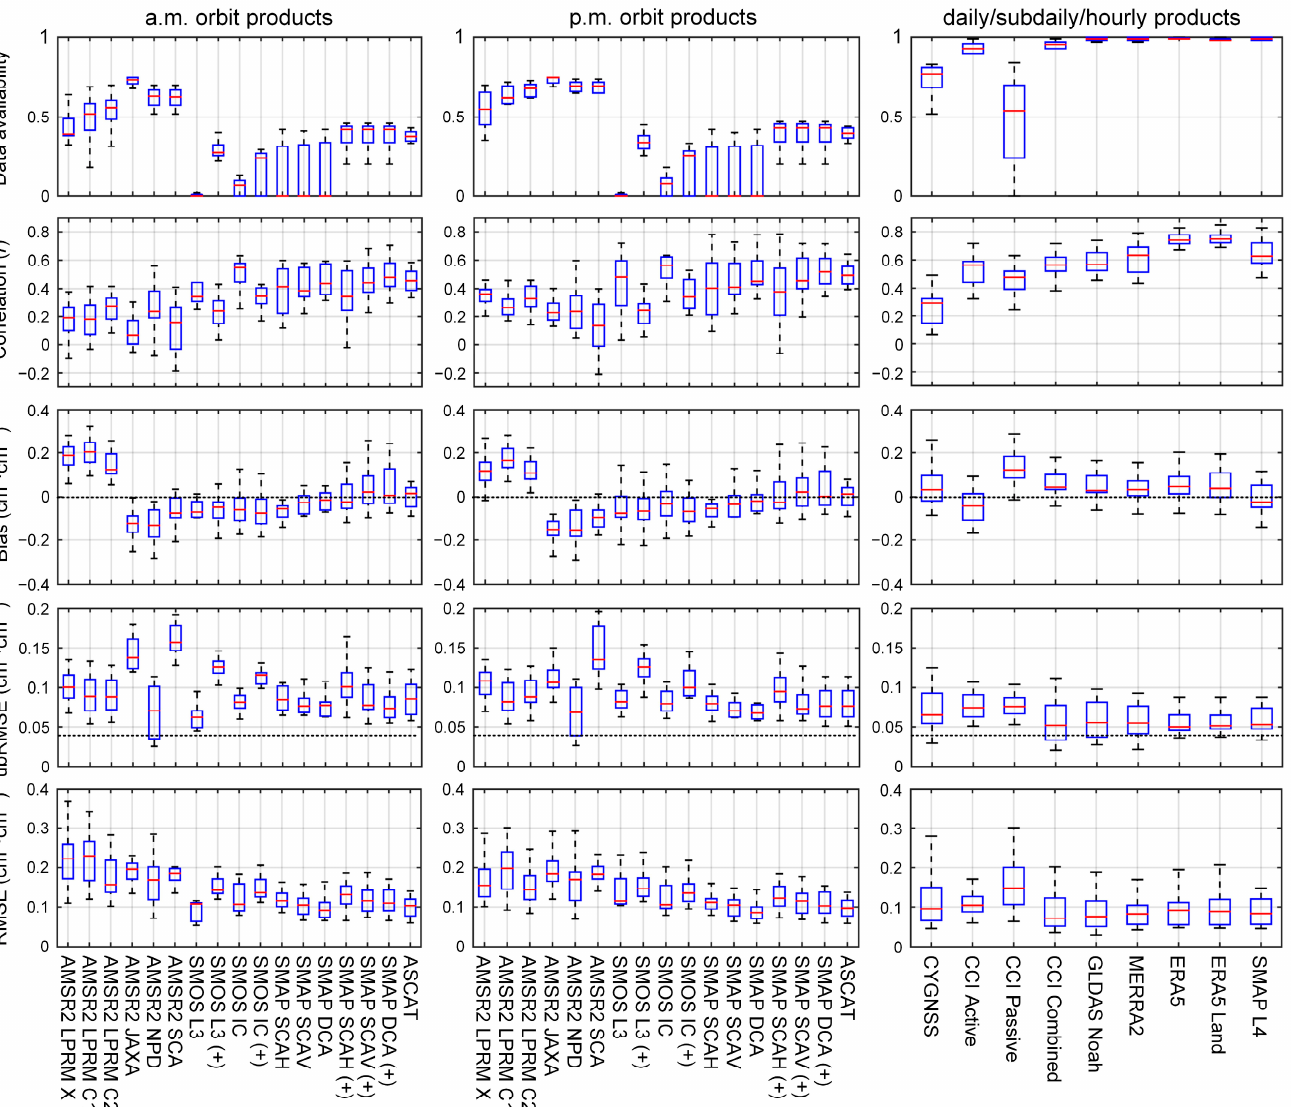
Figure 2. Data availability and evaluation results of soil moisture products. Data availability means the proportion of quality assured SM data, and each boxplot shows the distribution of metrics values at the 20 stations. The symbol “(+)” means a relaxed flagging strategy for L-band products. The first column shows the results in the a.m. orbit, the second column shows the results in the p.m. orbit, and the last column shows the results of daily or modeling-based products.